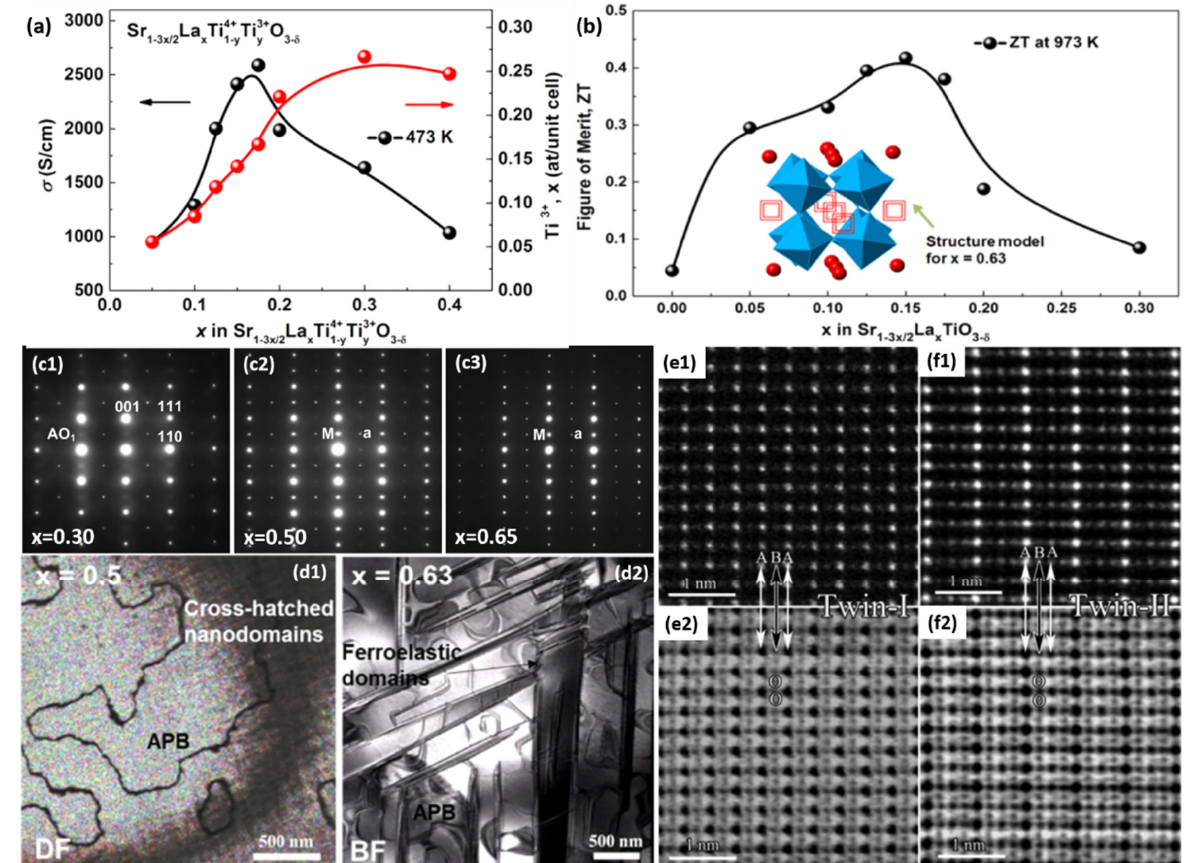
Figure 5. Vacancy ordering in SrTiO3-based thermoelectric oxide and influence on thermoelectric properties. ( a ) σ versus x at 473 K (black line) and Ti 3+ content versus x in Sr 1 − 3 x /2 La x TiO 3- δ ceramics sintered at 1773 K (red line) for 6 h in N 2 /5% H 2 . ( b ) ZT at 973 K versus x in Sr 1 − 3 x /2 La x TiO 3- δ ceramics. ( c1 – c3 ) {110} zone axis diffraction patterns from Sr 1 − 3 x /2 La x TiO 3 ceramics; Superstructure reflections are indicated. ( d1 , d2 ) Dark-field and bright-field TEM images of Sr 1 − 3 x /2 La x TiO 3 for ceramics with x = 0.50 and 0.63. ( e1,e2 ), and ( f1,f2 ) atomic resolution STEM HAADF/ABF images of two domains of Sr 1 − 3 x /2 La x TiO 3 ( x = 0.63) ceramic, showing A-site vacancy ordering along the {100} direction. Reproduced from Ref. [146] Copyright 2016 American Chemical